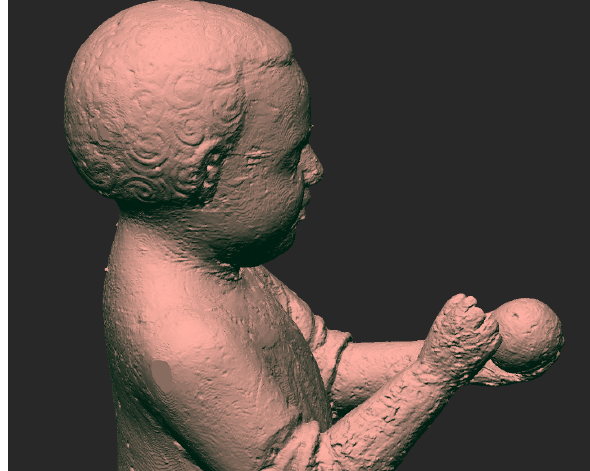
Figure 9: 3D surface of the infant based on the CT images